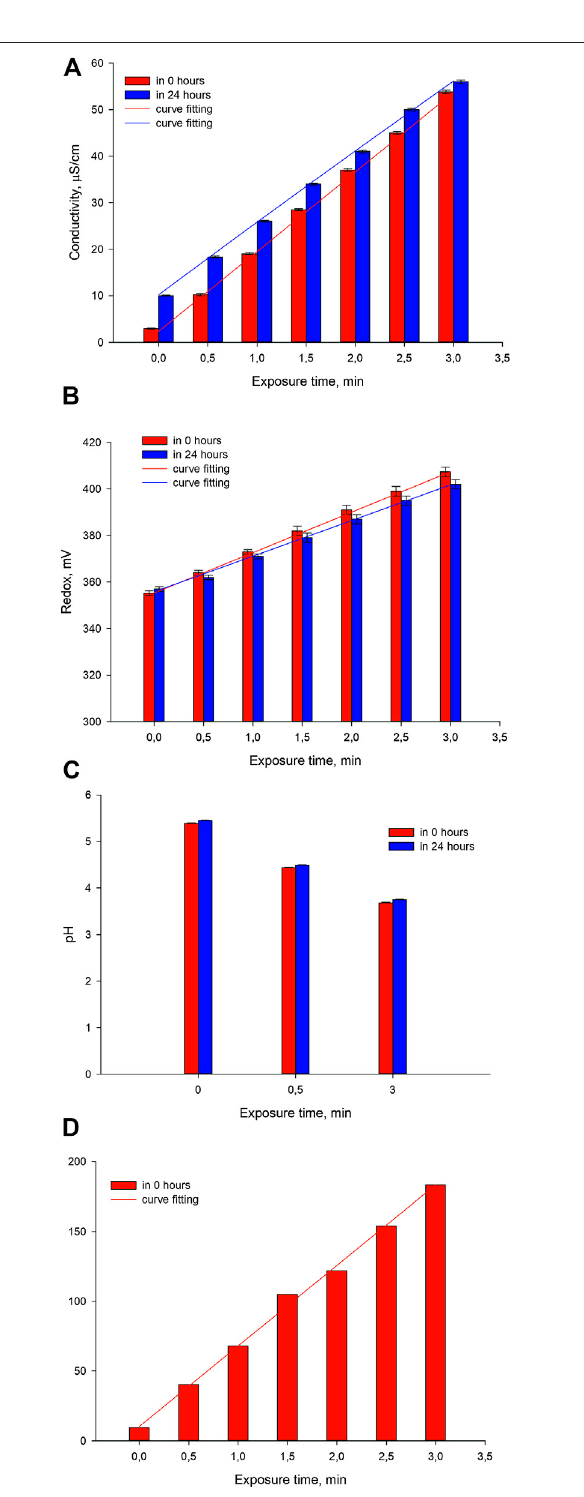
FIGURE 9 | Dependence of the treated media conductivity (A) , redox potential (B) , pH (C) , and H2O2 concentration (D) on the exposure time. Measurements were taken immediately after processing and 24 h after